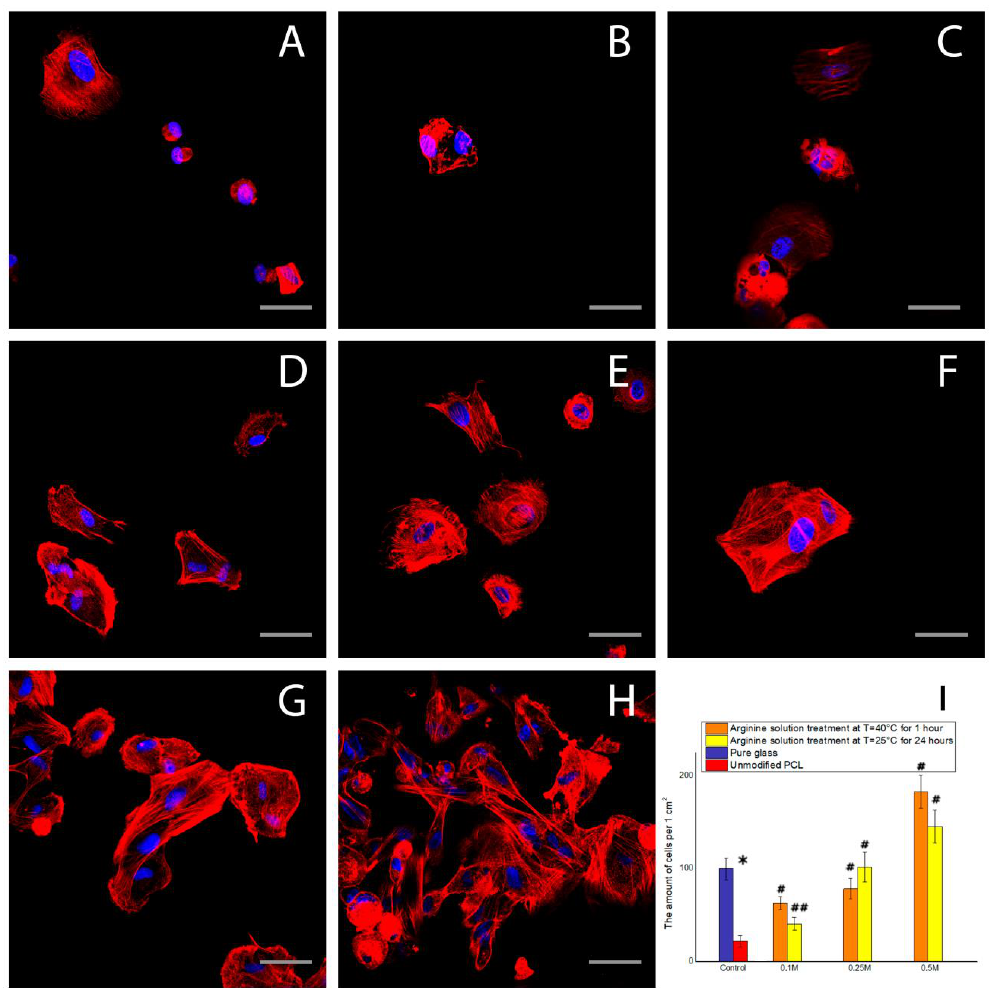
Figure 5. Fluorescence microscopy of the MSC cells after 2 h of cultivation: ( A ) on the pure glass, ( B ) on the unmodified PCL, ( C ) on the film treated with the 0.1 M arginine solution for 1 h at T = 40 °C, ( D ) on the film treated with the 0.25 M arginine solution for 1 h at T = 40 °C, ( E ) on the film treated with the 0.5 M arginine solution for 1 h at T = 40 °C, ( F ) on the film treated with the 0.1 M arginine solution for 24 h at T = 25 °C, ( G ) on the film treated with the 0.25 M arginine solution for 24 h at T = 25 °C, ( H ) on the film treated with the 0.5 M arginine solution for 24 h at T = 25 °C, and ( I ) the dependence of the amount of MSC cells on the modification conditions after 2 h of cultivation (n = 5: *—p < 0.01 for the same concentration data, #—p < 0.01, ##—p < 0.05 compared with the unmodified PCL). Scale bar 50 µm .